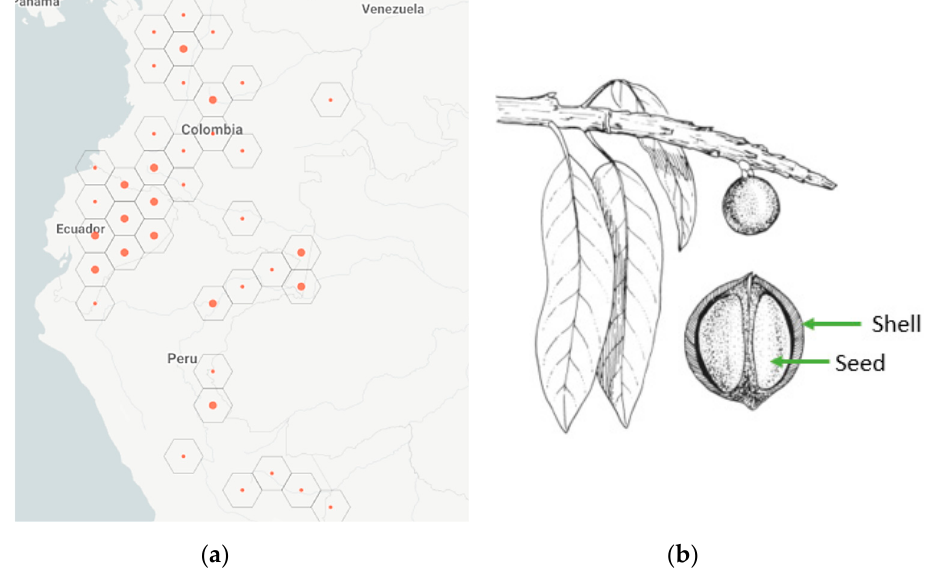
Figure 1. ( a ) Metohuayo’s growing regions [4]; ( b ) composition of the Metohuayo fruit [5].